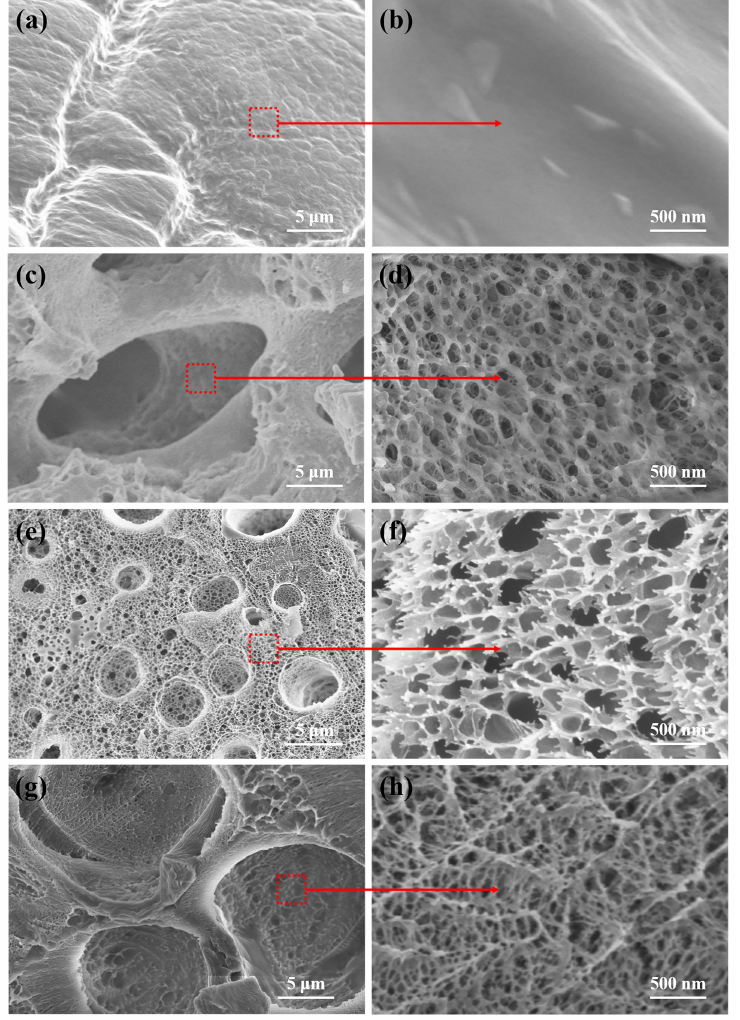
Figure 3. The cross-section SEM images of samples under different magnification: ( a , b ) pure PVA hydro- gel, ( c , d ) BPVA-Pluronic-3 hydrogel, ( e , f ) BPVA-Pluronic-5 hydrogel, ( g , h ) BPVA-Pluronic-6